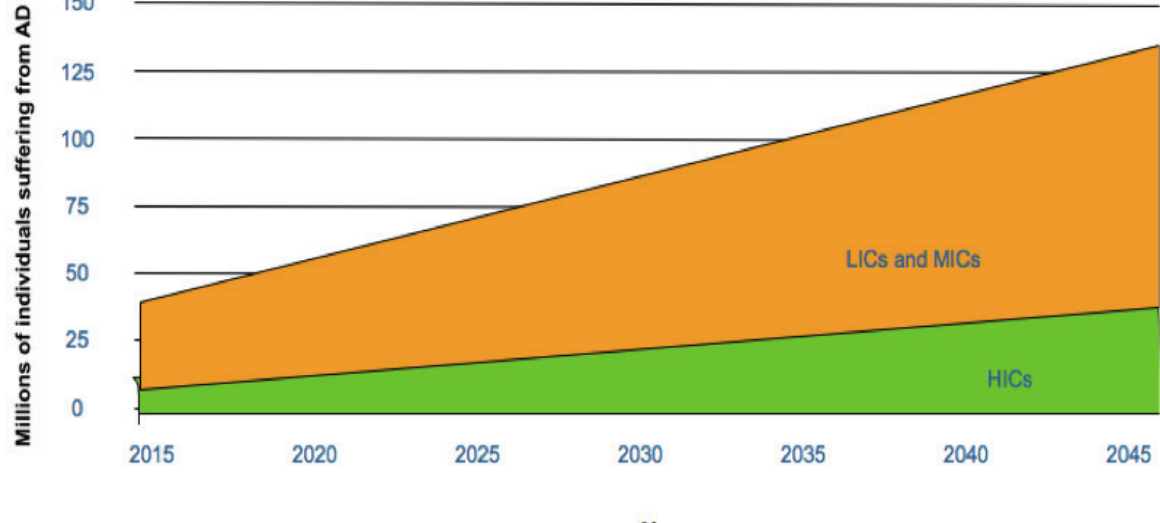
Figure 6. Number of individuals with AD in countries of varying GNI